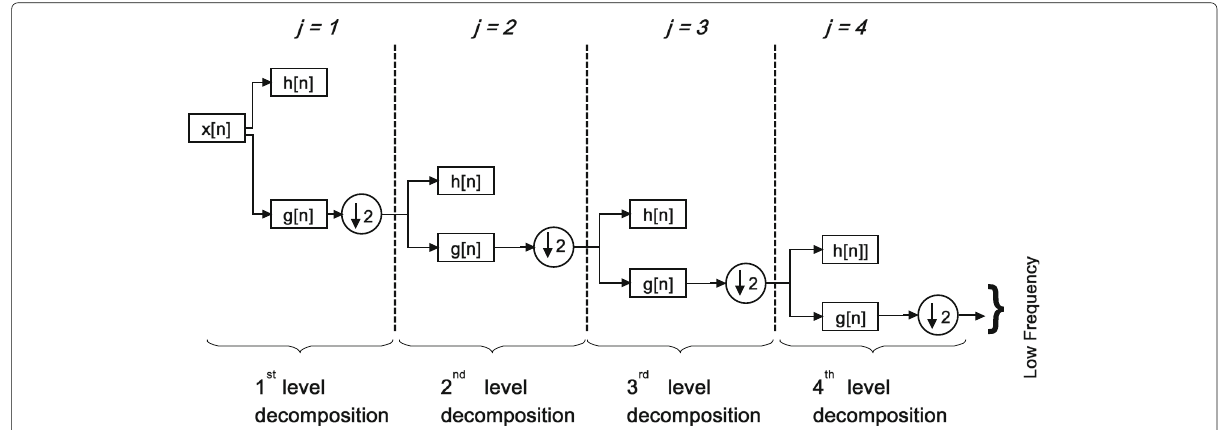
Fig. 3 The block diagram of a two-channel four-level DWT decomposition ( J = 4) that decomposes a discrete signal into two